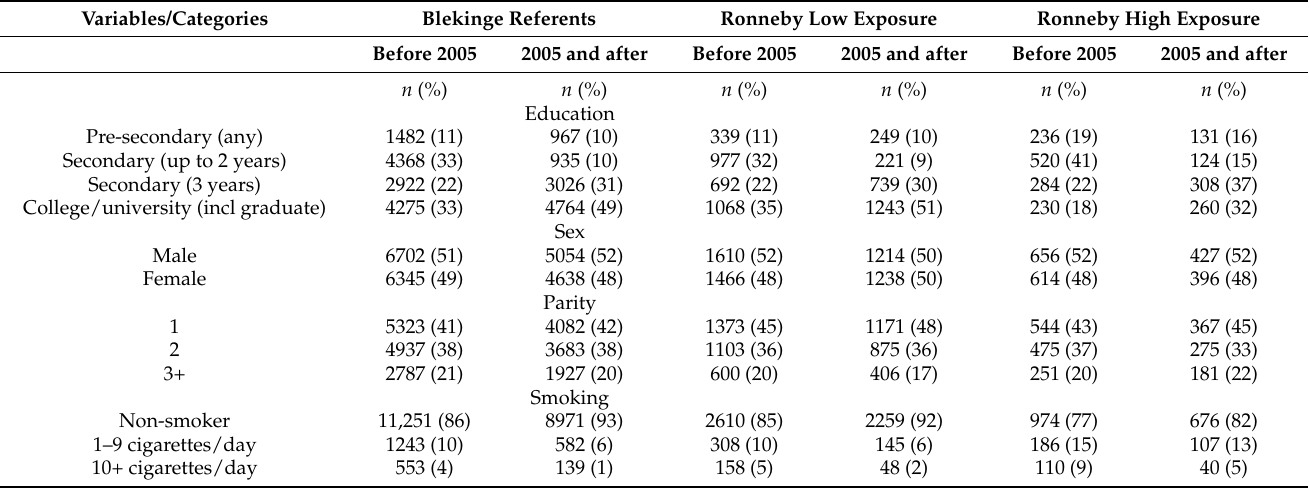
Table 1. Descriptive data by exposure group and period, categorical